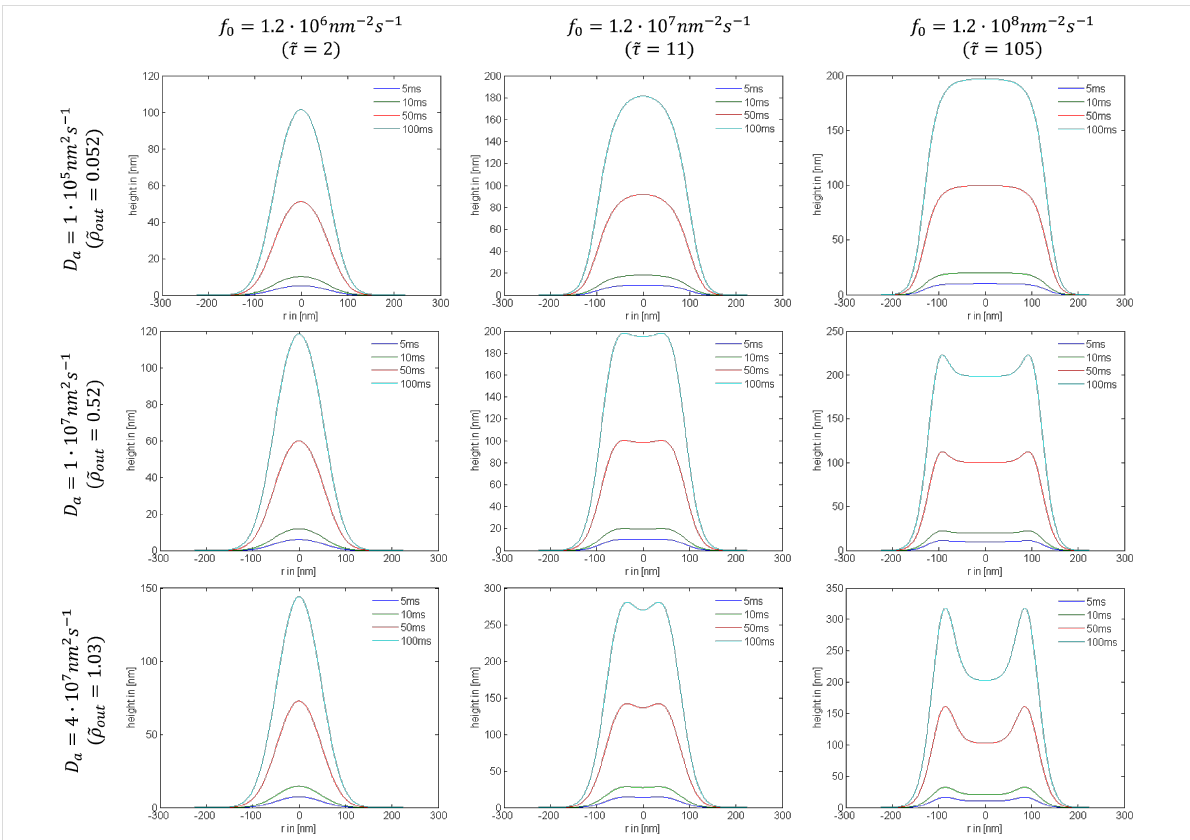
Figure 20: Examples of deposit geometries simulated using exposure times ( t ) of 5 ms; 10 ms; 50 ms; 100 ms, a Gaussian beam profile, and selected values of the maximum electron flux f 0 and surface diffusion coefficient D a ( s a = 1, F a = 10 4 nm − 2 s − 1 , n 0 = 2 nm − 2 , τ a = 100 μ s, σ a = 0.013 nm 2 , V a = 0.2 nm 3 and FWHM = 100